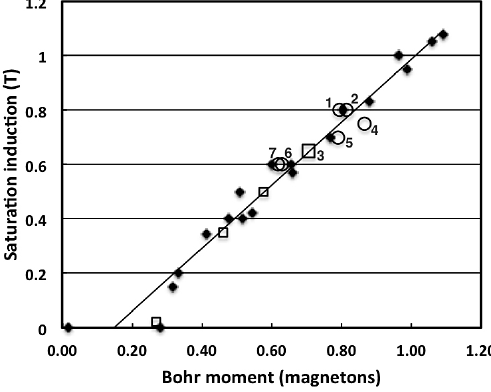
Figure 14. Saturation total magnetic flux density vs. average atomic moment. Data are from Neumann (1934), von Auwers and Neumann (1935) or Bozorth (1993), or are calculated estimates. Large, open symbols represent alloys: (1) 14% Cu, (2) mumetal, (3) 6–81, (4) 4–79, (5) supermalloy, (6) “1040”, and (7) 28% Cu. Small symbols represent B s data for a range of ternary